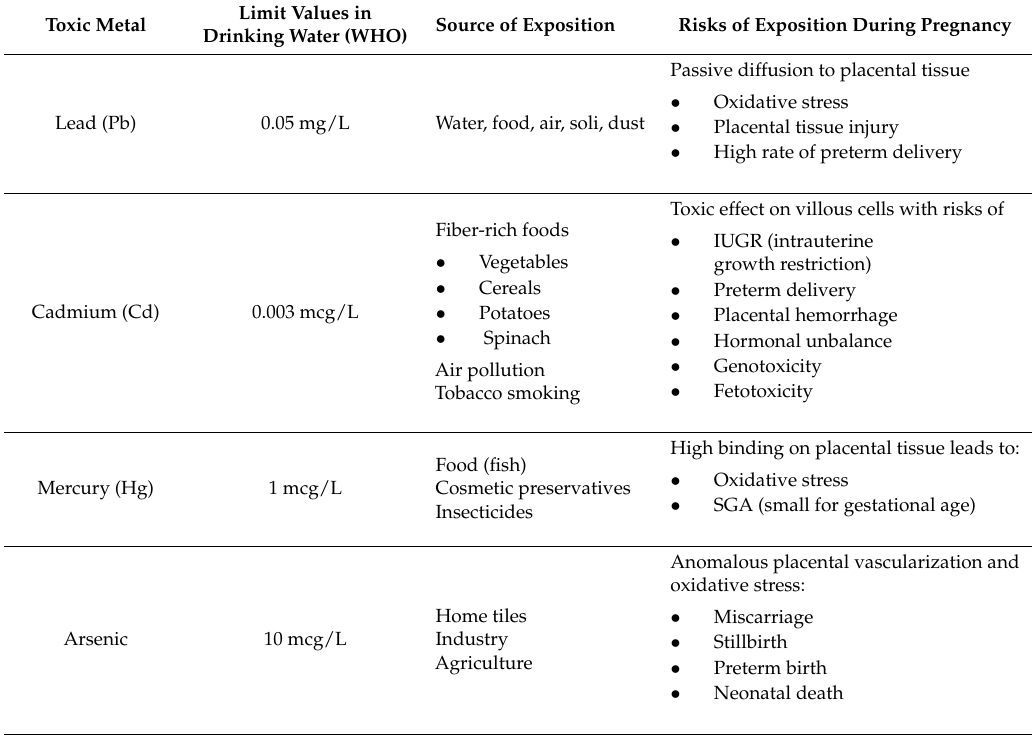
Table 1. Possible effects of exposure to toxic metals during